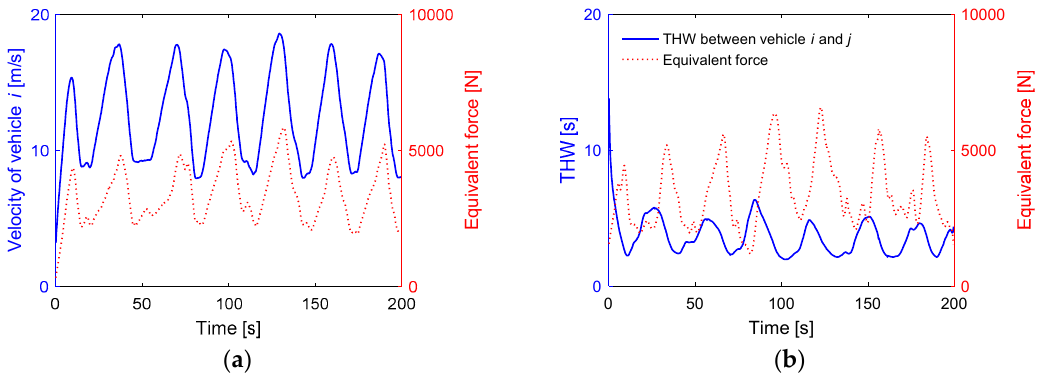
Figure 11. Experiment results in the car following scenario . ( a ) The relationship between the velocity of vehicle i and the equivalent force F i at the position of vehicle j ; ( b ) the relationship between the time headway and the equivalent force F i at the position of vehicle j